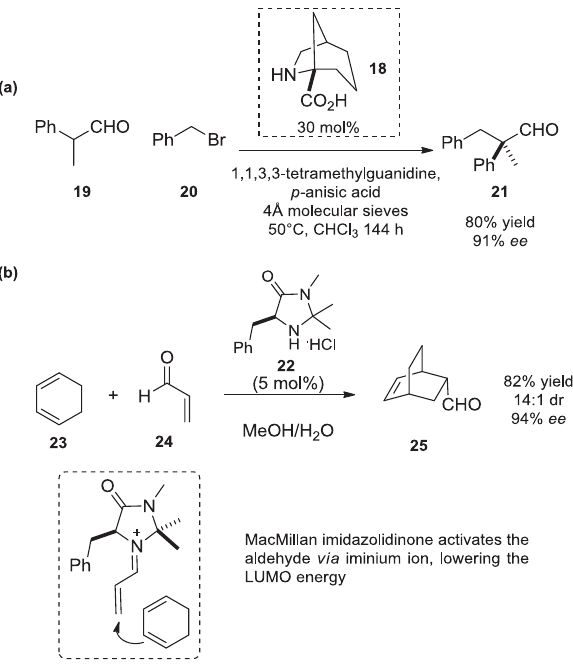
Figure 7. (a) Asymmetric alkylation of α -branched aldehydes catalyzed by secondary amine 18; (b) direct Diels – Alder reaction catalyzed by MacMillan imidazolidinone